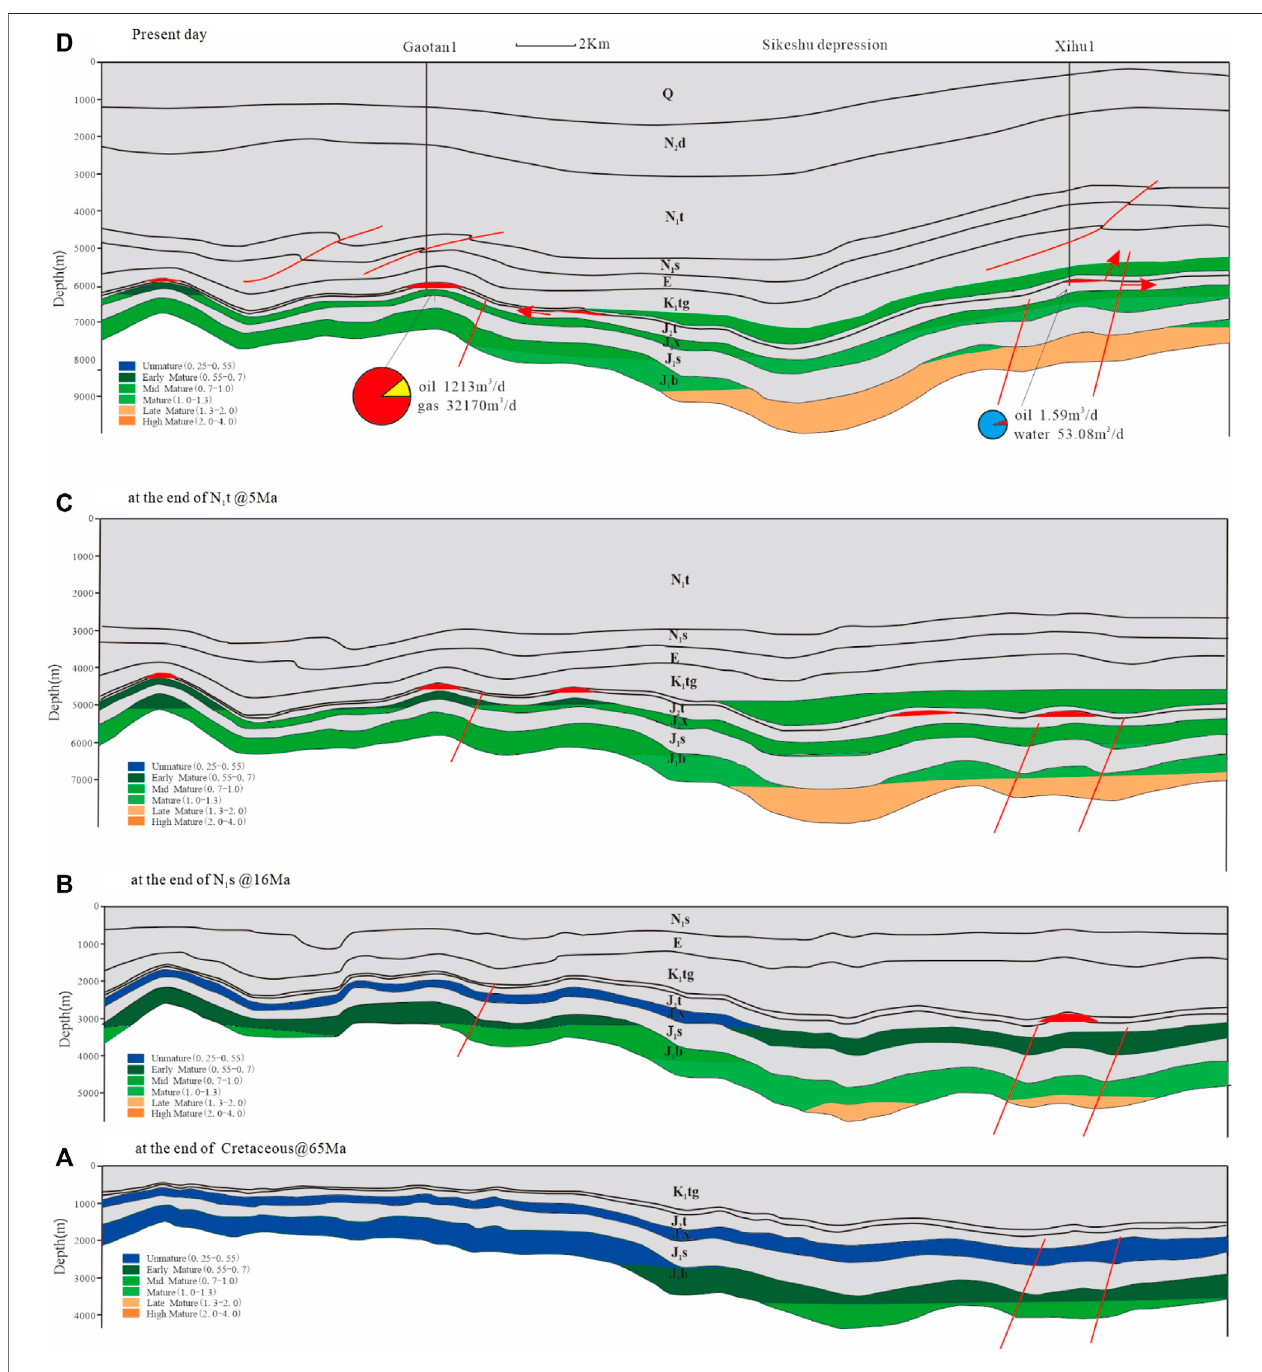
FIGURE 16 | Schematic diagram of tectonic deformation, source rock maturation, and hydrocarbon accumulation history in the west segment of the South Junggar foreland basin. The location of this section is shown in Figure 1 . (A) The structure, source rock maturation and HC accumulation situation at the end of Cretaceousat65Ma. (B) Thestructure,sourcerockmaturationandHCaccumulationsituationattheendofN1ssedimentationat16Ma. (C) Thestructure,sourcerock maturation and HC accumulation situation at the end of N1t sedimentation at 5 Ma. (D) The structure, source rock maturation and HC accumulation situation at present